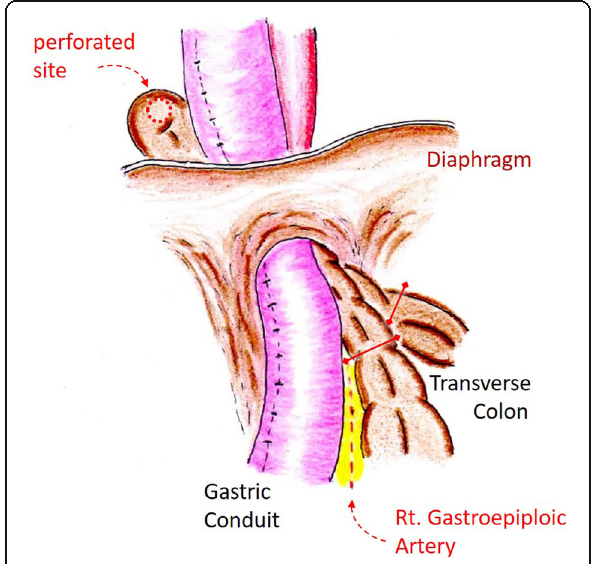
Fig. 2 Schema of operative findings. This schema shows the prolapse of the transverse colon through the left side of diaphragmatic hiatal defect into the mediastinum around the back of the gastric conduit. Incarcerated herniation of the transverse colon was perforated in the mediastinum and was resected, as seen by the red lines. The liver was omitted in this